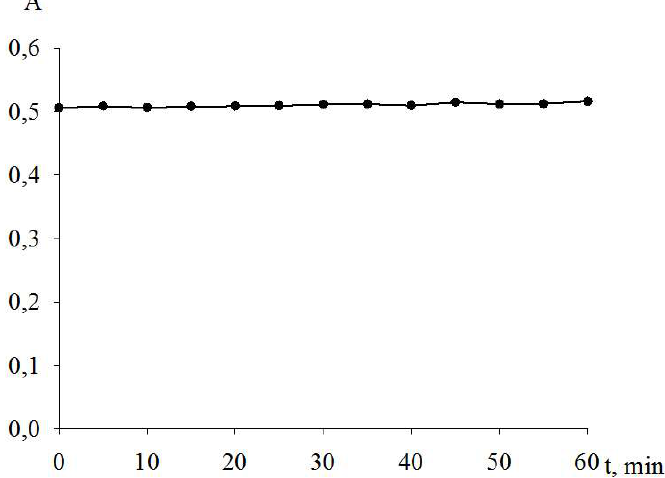
Fig. 2. The spectrum of absorption of the reaction product of sotalol with diazole red 2J